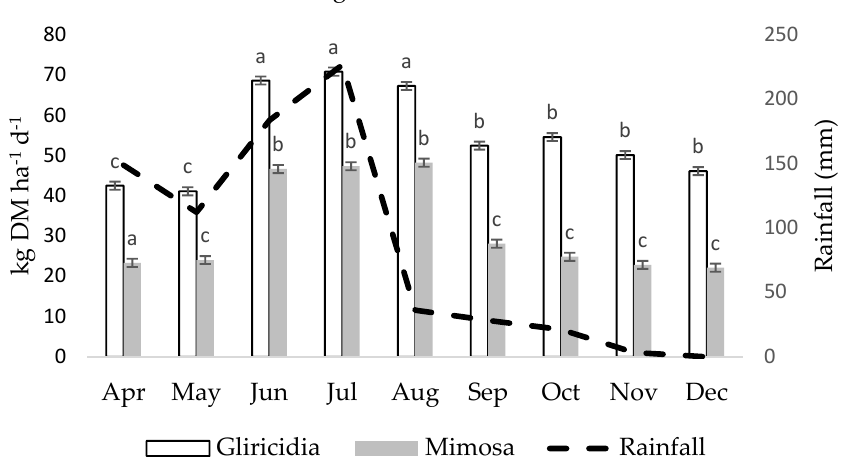
Figure 5. Herbage accumulation rate for Gliricidia and Mimosa during the experimental period (SE = 1.5 kg DM ha − 1 d − 1 ). Letters are comparing treatments within each evaluation month. Similar letters are not different according to PDIFF adjusted by Tukey ( p > 0.05). SPS = silvopasture system.